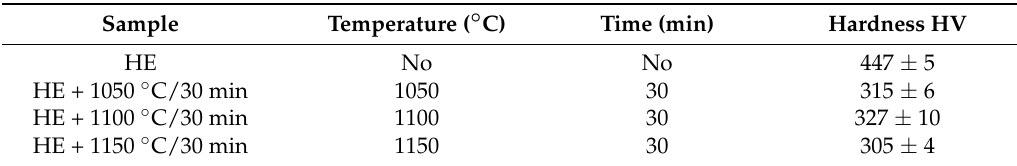
Table 1. The ODS material has been examined in as-prepared condition (samples HE) and after heat treatments at three different temperatures (1050, 1100, and 1150 ◦ C) for 30 min. The corresponding final hardness is reported.